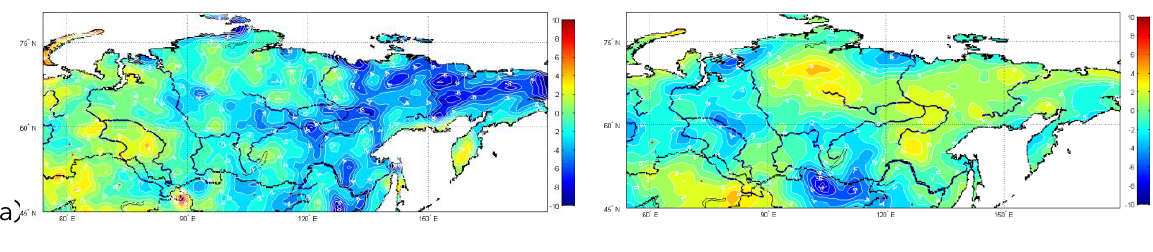
. W/m 2 /decade) (b) and effective radiation trend 3 ↓S